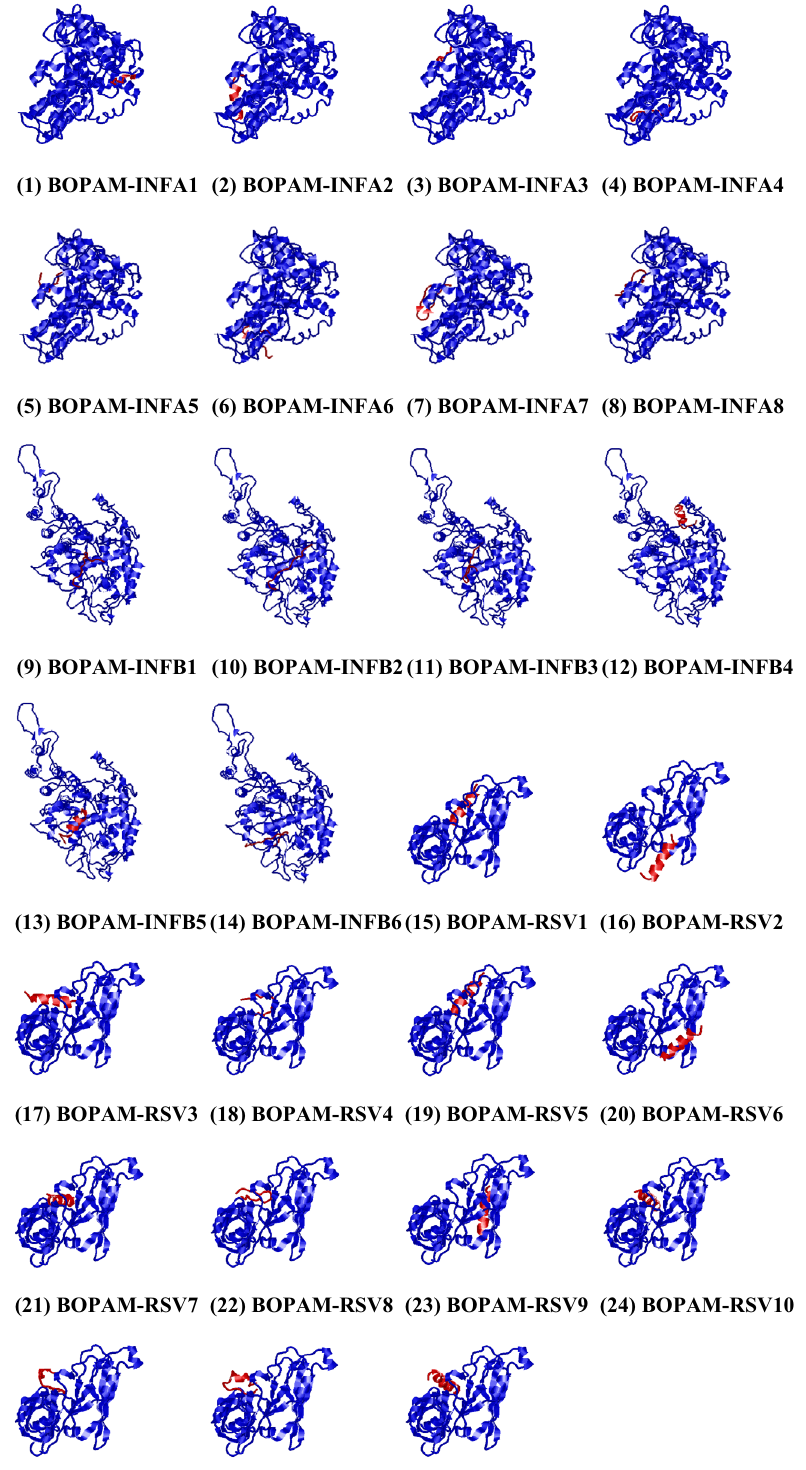
Figure 2. Docking interaction of the pneumonia protein receptors and putative anti-pneumonia AMPs produced from PATCHDOCK (https:// bioin fo3d. cs. tau. ac. il/ Patch Dock/ php. php) 32 and visualized using PyMOL version 1.3 30 .. The structure in colour blue represents the receptor proteins with the ligand depicted in red with their orientations in their respective